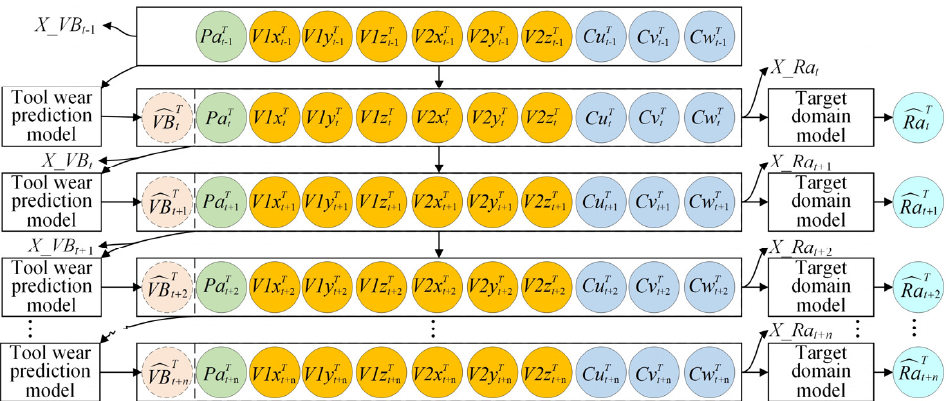
Figure 7. Surface roughness prediction integrating tool wear.